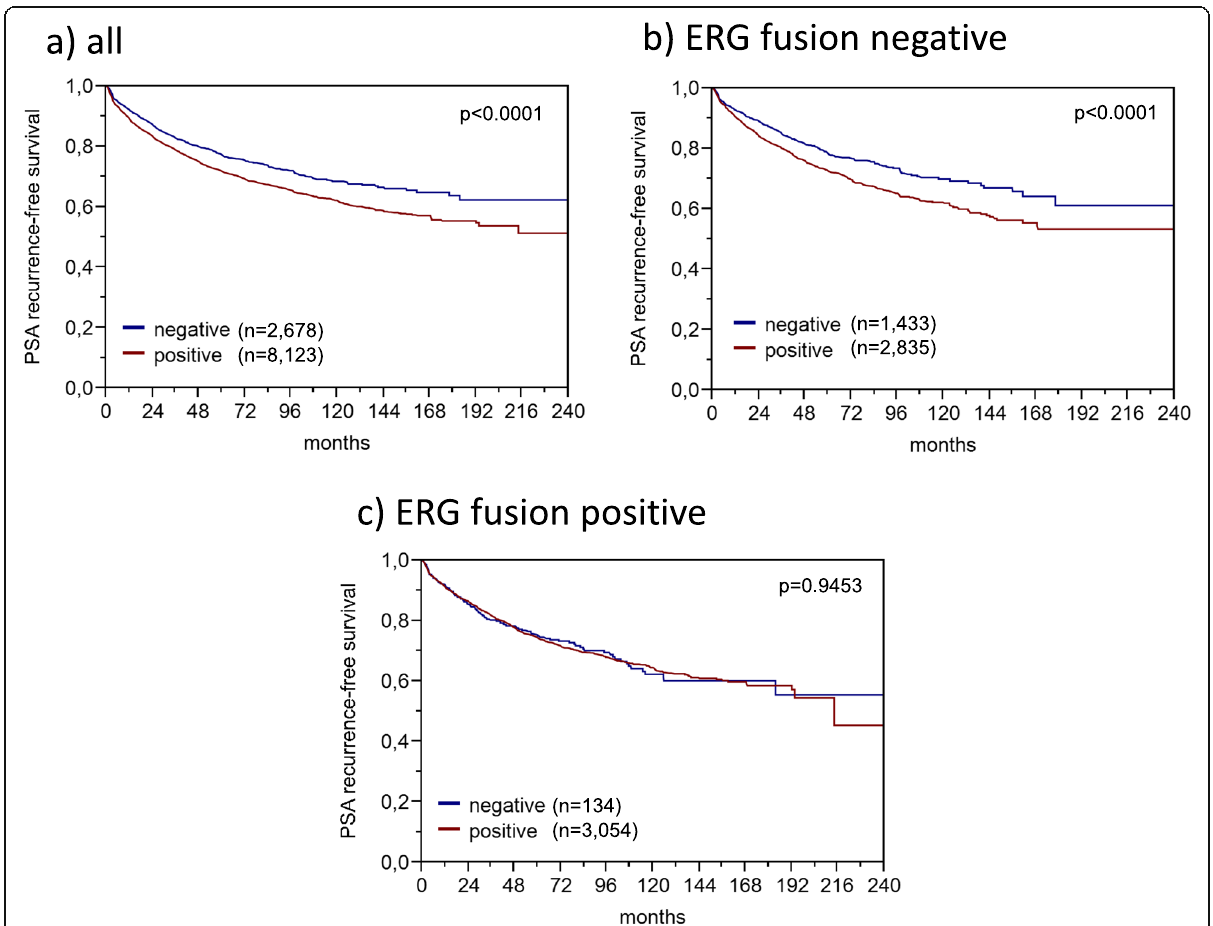
Fig. 3 Kaplan-Meier plot of prostate specific antigen (PSA) recurrence-free survival after radical prostatectomy and immunostaining of TFAP2D in a all cancers, b the ERG negative, and c the ERG positive